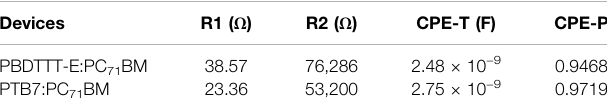
TABLE 3 | Electrical parameter values in blend devices.